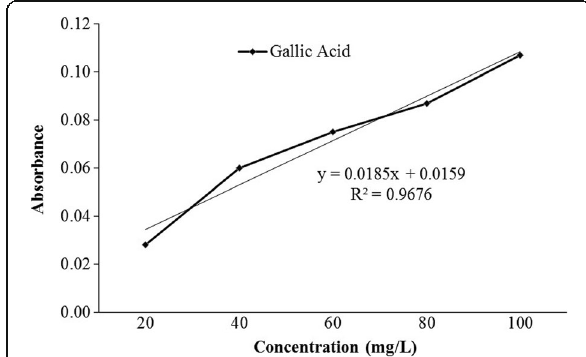
Fig. 4 Gallic acid standard calibration curve for the determination of